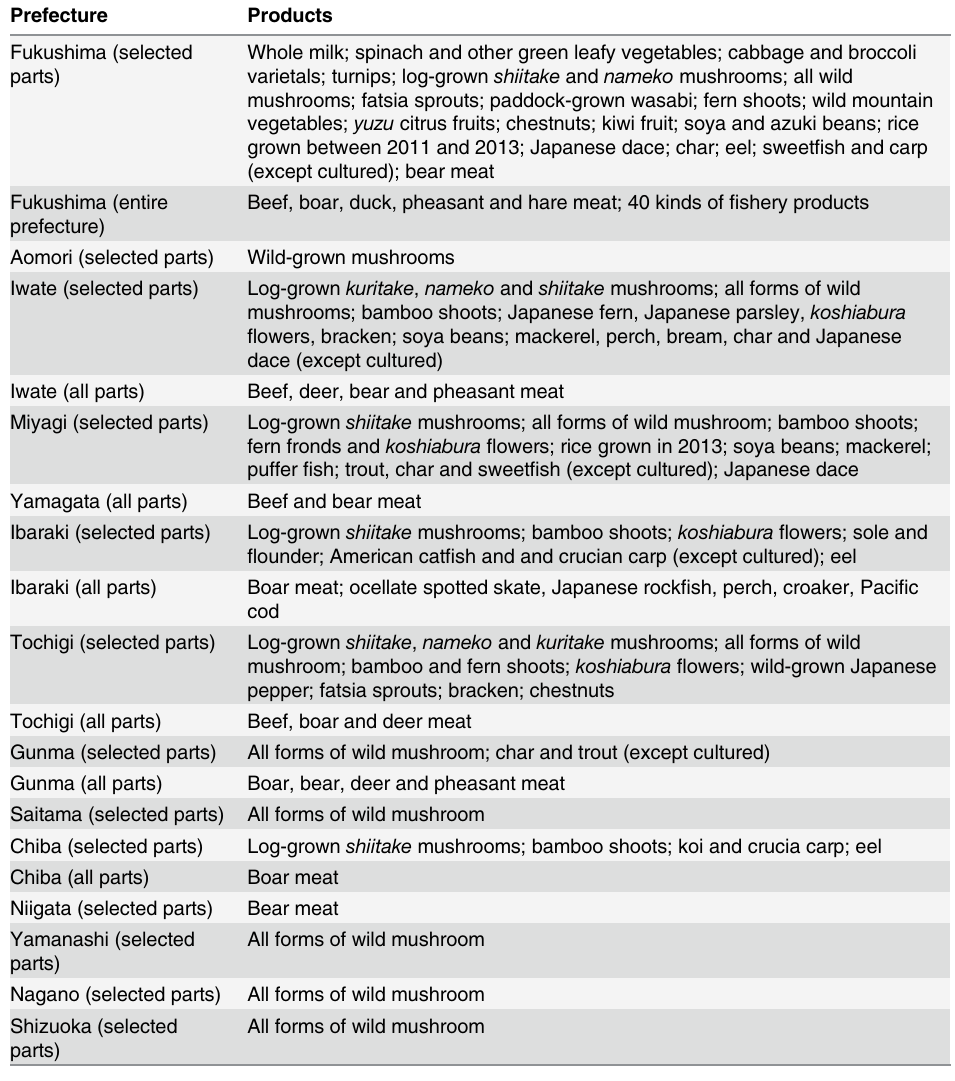
Table 4. Restrictions on goods for sale or distribution by Prefecture, December